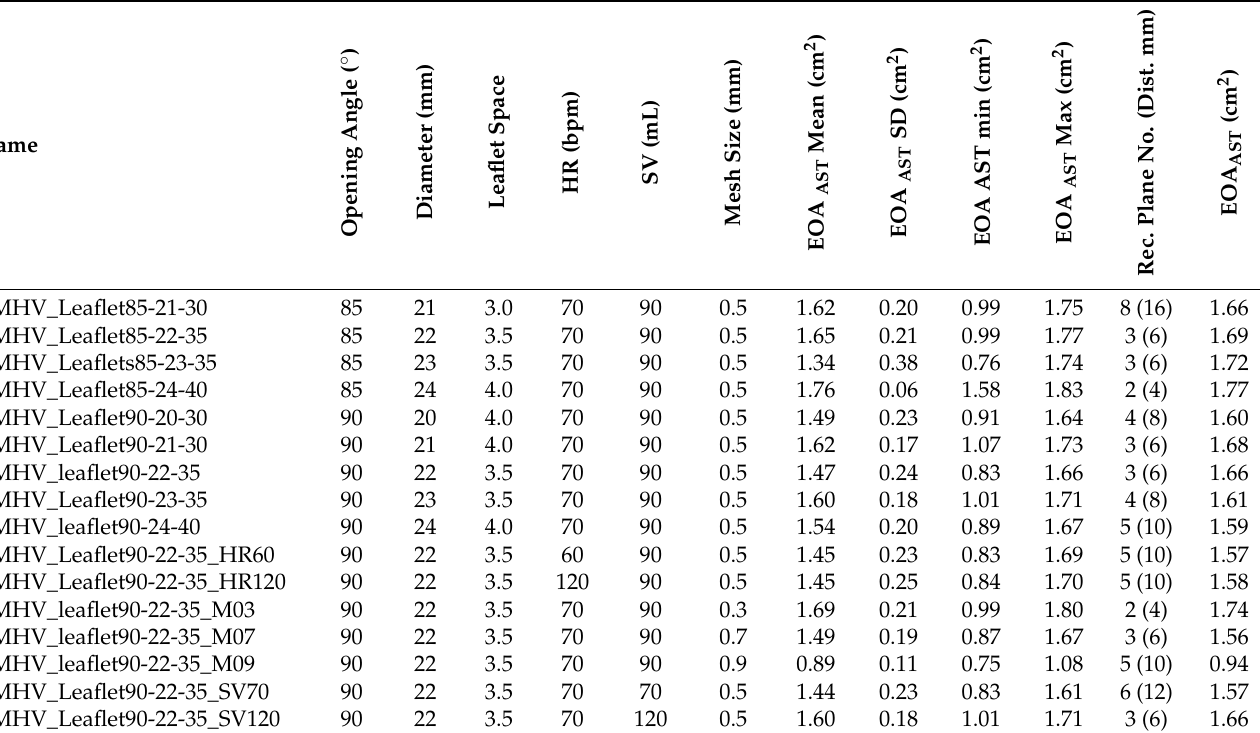
Table 3. Numerical simulation setting (geometrical parameters of the BMHV) and results: EOA AST computation (mean, max, and mean) and location of the recording